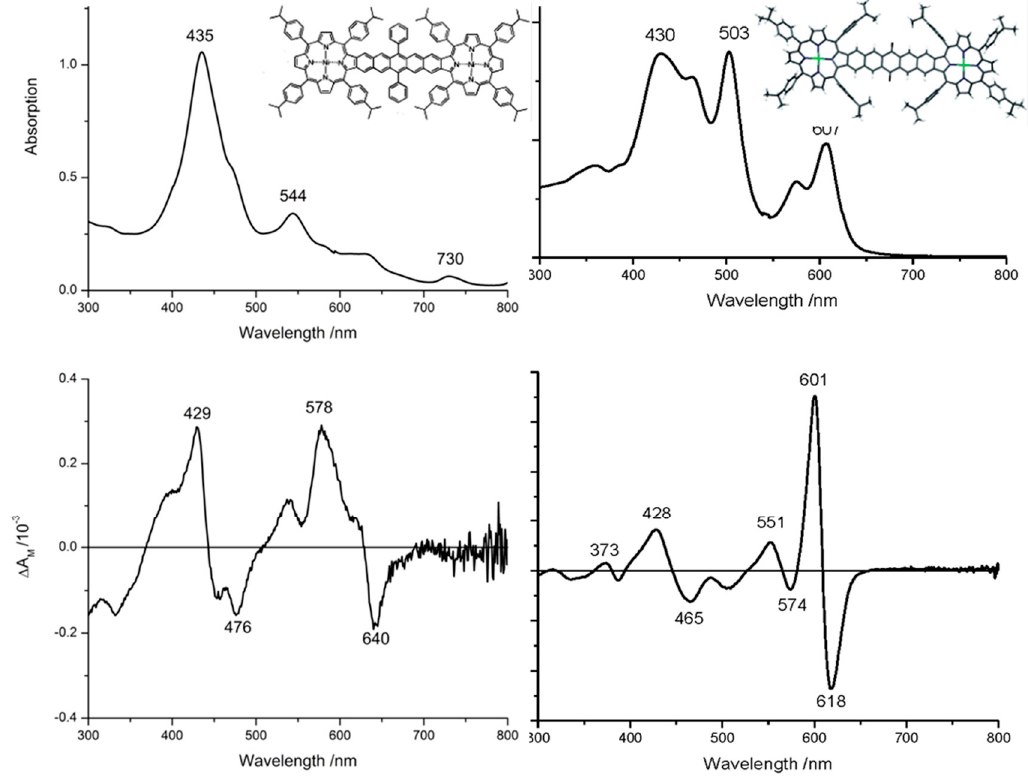
Figure 17. Absorption and MCD of the pentacene-fused Ni-diporphyrin, Compound 1a ( Left ) and the quinone-dinaphtho-Ni-diporphyin, Compound 2a ( Right ). The molecular structures are shown in Figure 14. Adapted from and reproduced with permission, Jiang et al. [102].